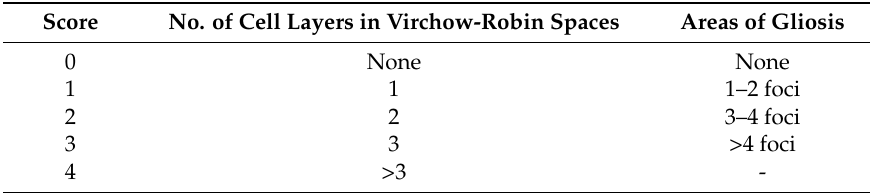
Table 3. Histopathologic severity